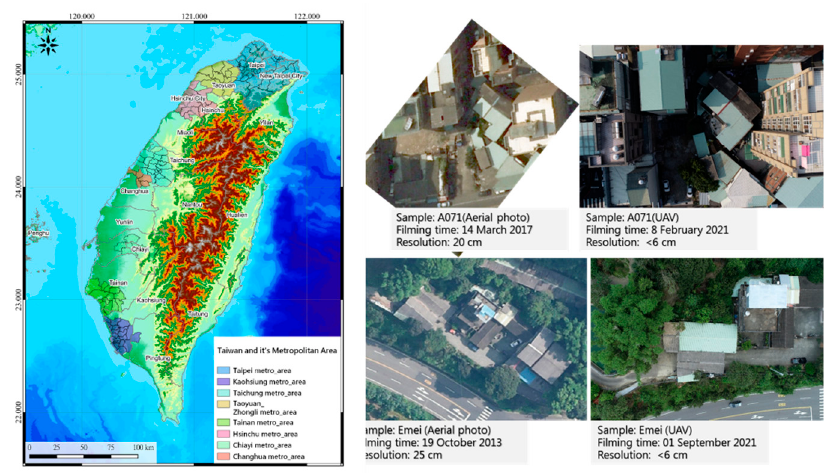
Figure 1. ( Left ) The elevation and distribution of major cities in Taiwan. ( Right ) Samples of available imagery and various roofing types.